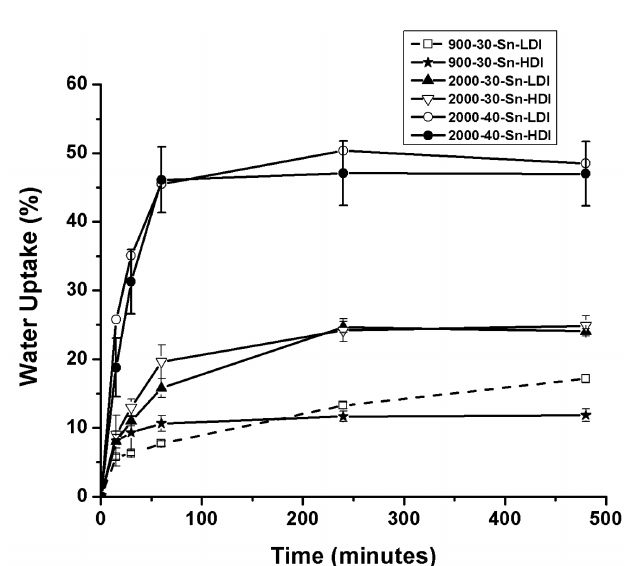
FIGURE 2 - Swelling characteristics of dry slabs in phosphate buffer (pH 7.4) at 37 TABLE III - Water uptake, erosion percent, and dissolution efficiency of polyurethane tablets